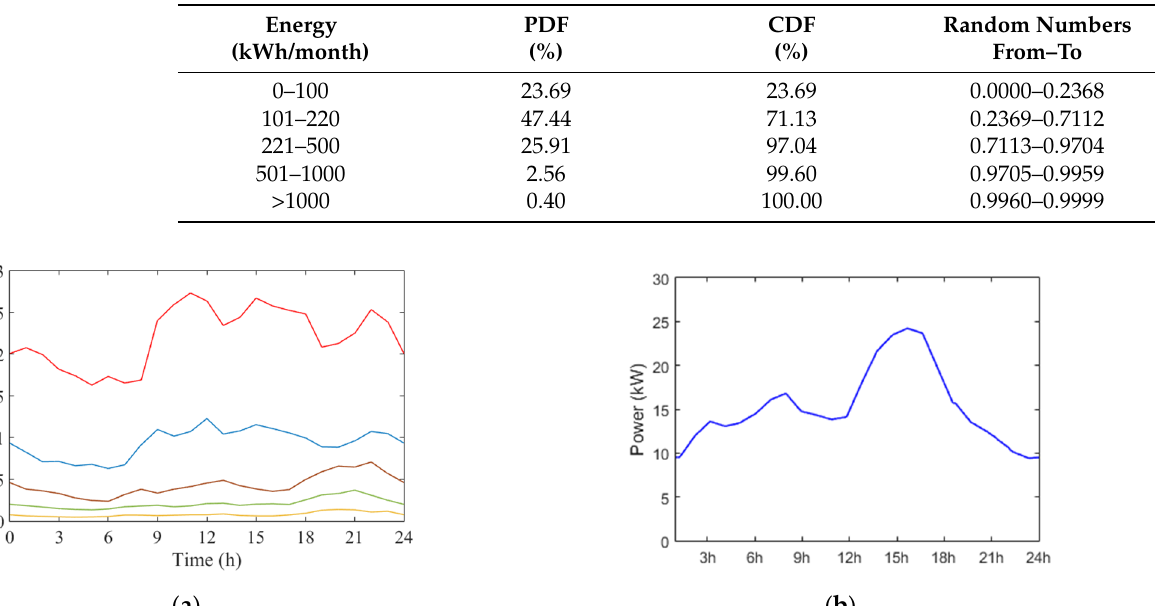
Table 2. Residential typical consumption [23].